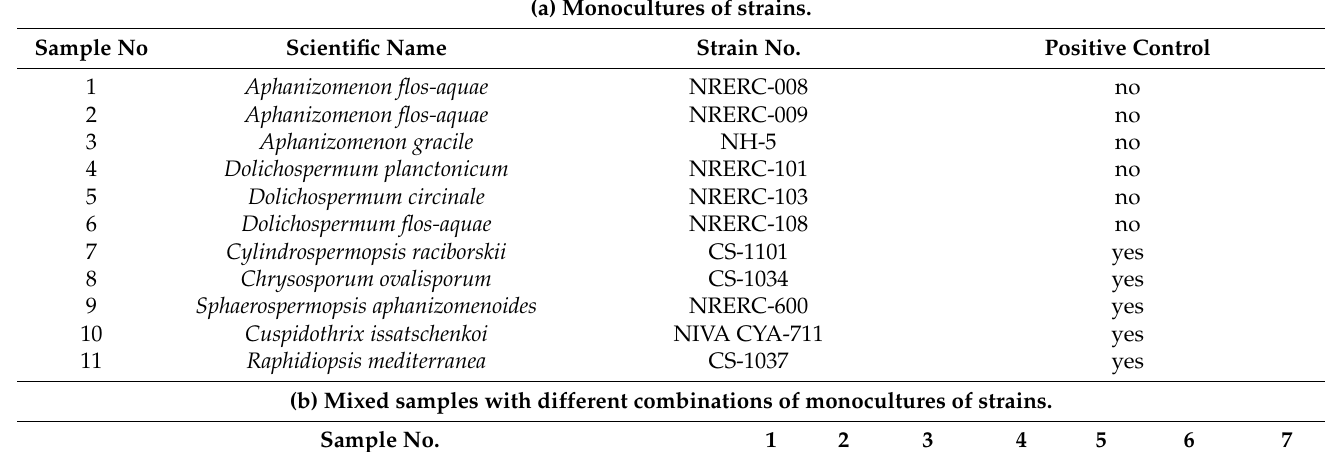
(b) Mixed samples with different combinations of monocultures of strains.